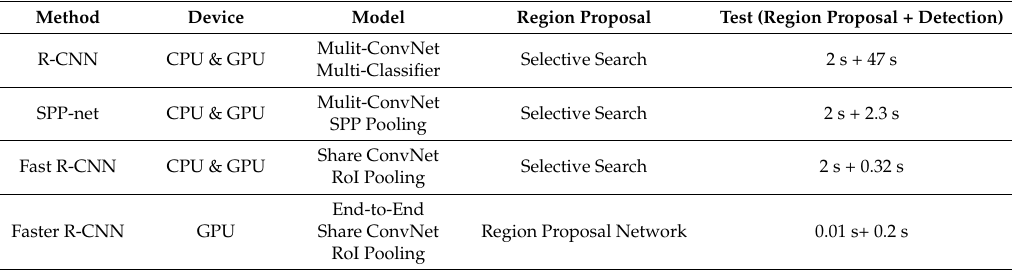
Table 1. Comparison of multi-object detection methods based on deep